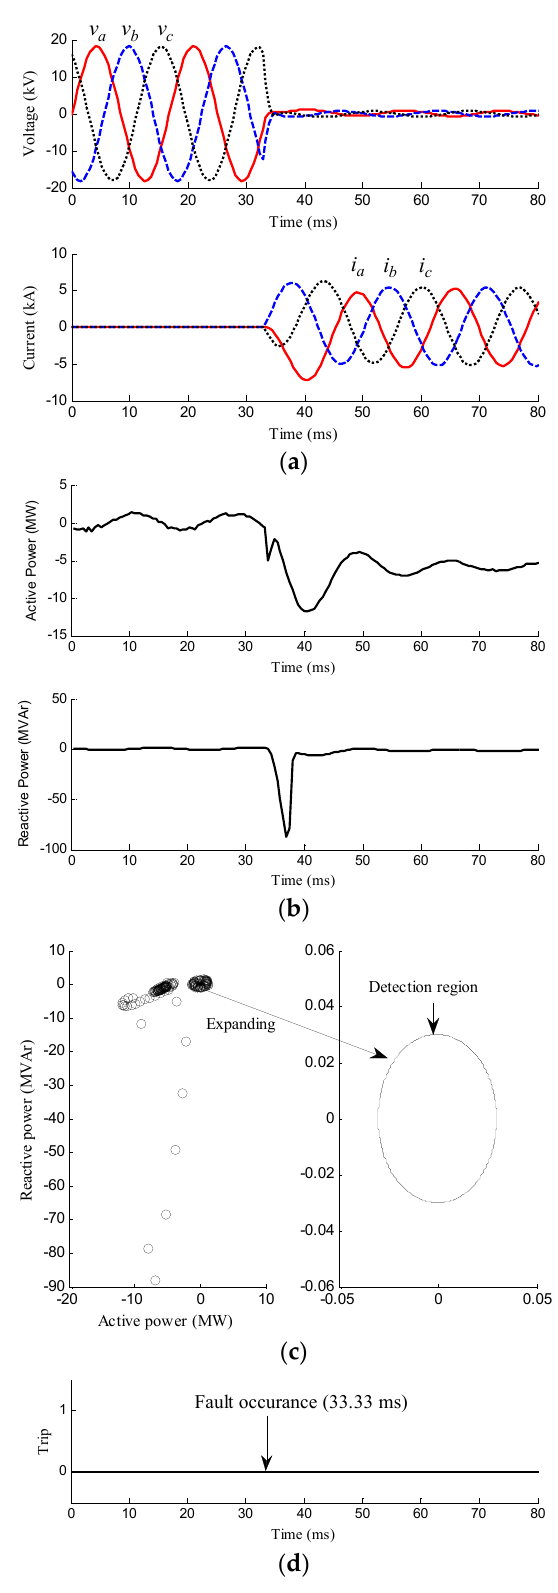
Figure 17. Hardware implementation results for Case 4. ( a ) v a , b , c (upper) and i a , b , c (lower); ( b ) p 3 ph (upper) and q 3 ph (lower); ( c ) Trajectories of the point ( p 3 ph , q 3 ph ); ( d ) Islanding detection signal.